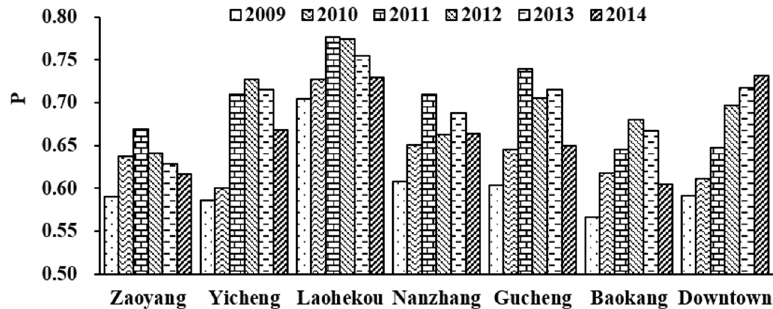
Figure 8. Temporal variation process of the overall harmonious development degree in Xiangyang City.